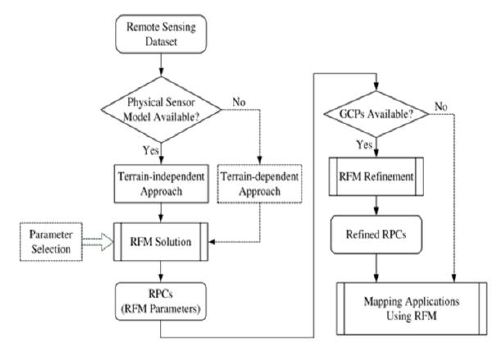
Figure 1. General workflow of developing an RF model